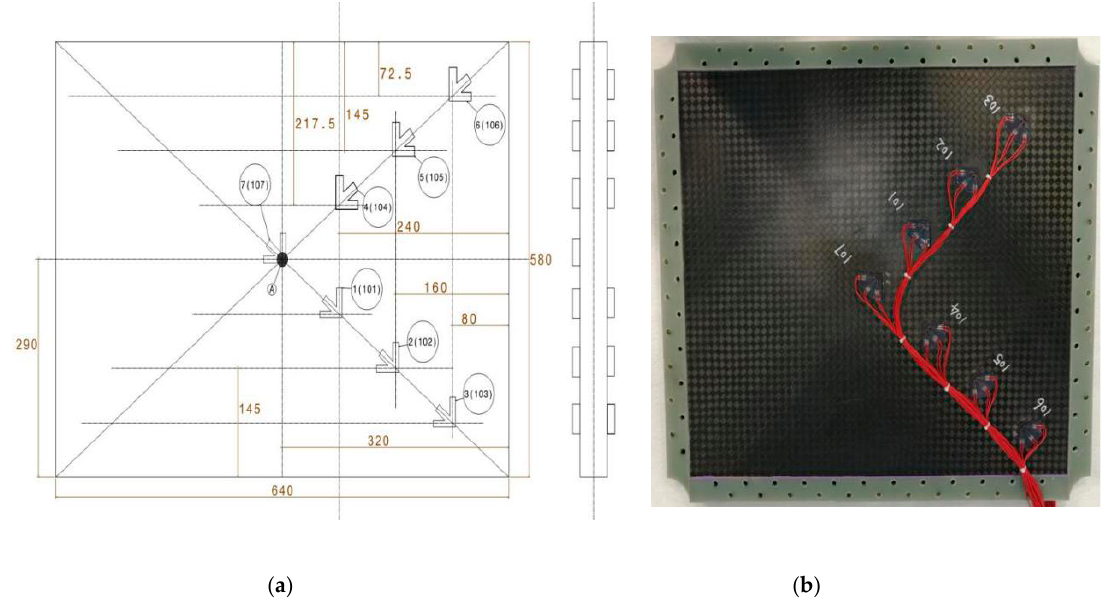
Figure 4. Position and number of strain gauge: ( a ) schematic diagram; ( b ) photo.